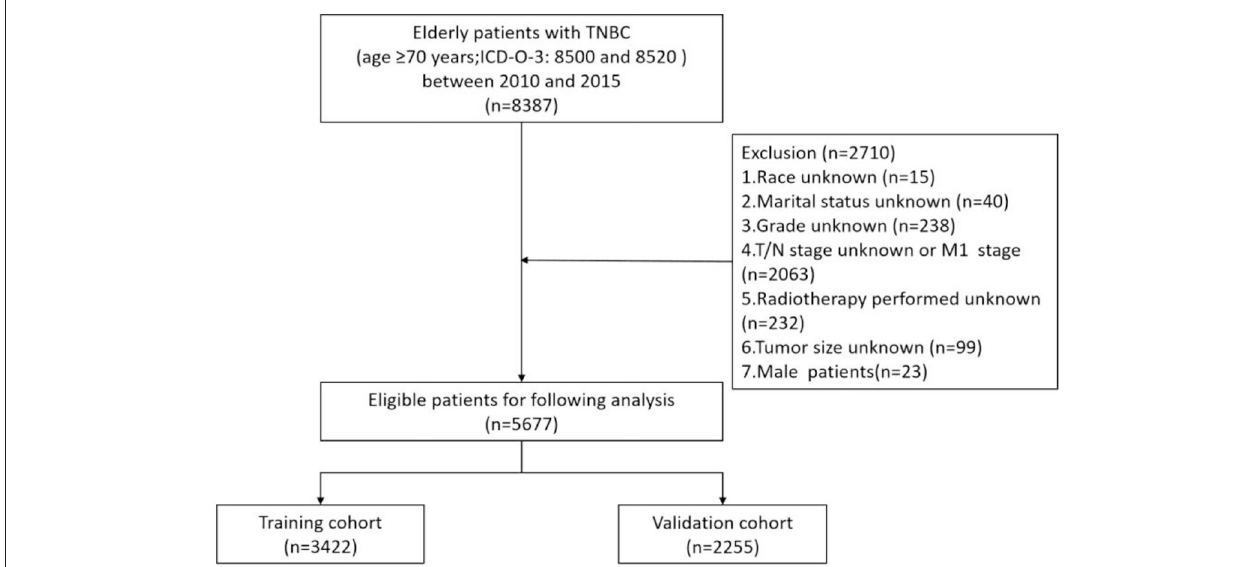
FIGURE 1 | Patient selection